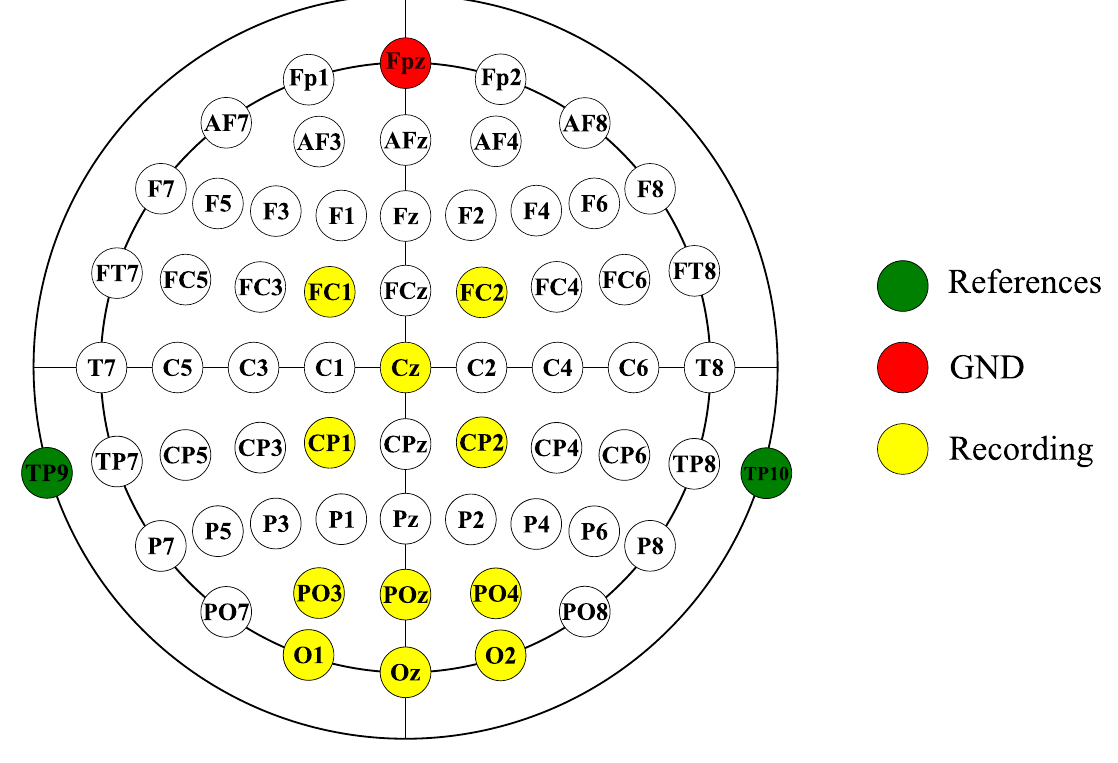
Figure 4. The EEG electrodes used in our study.